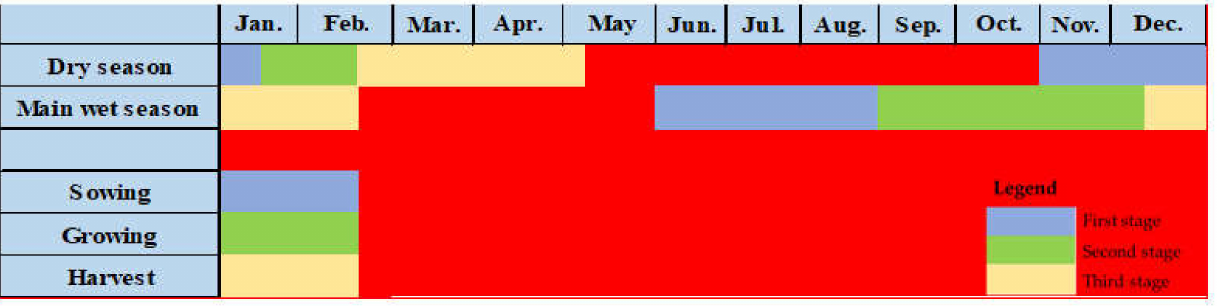
Figure 3. Paddy planting calendar for the study